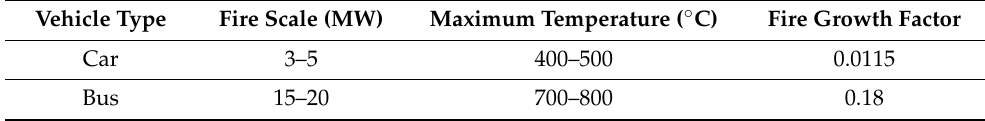
Table 4. Fire scale, smoke temperature, growth coefficient and burning time of different models.